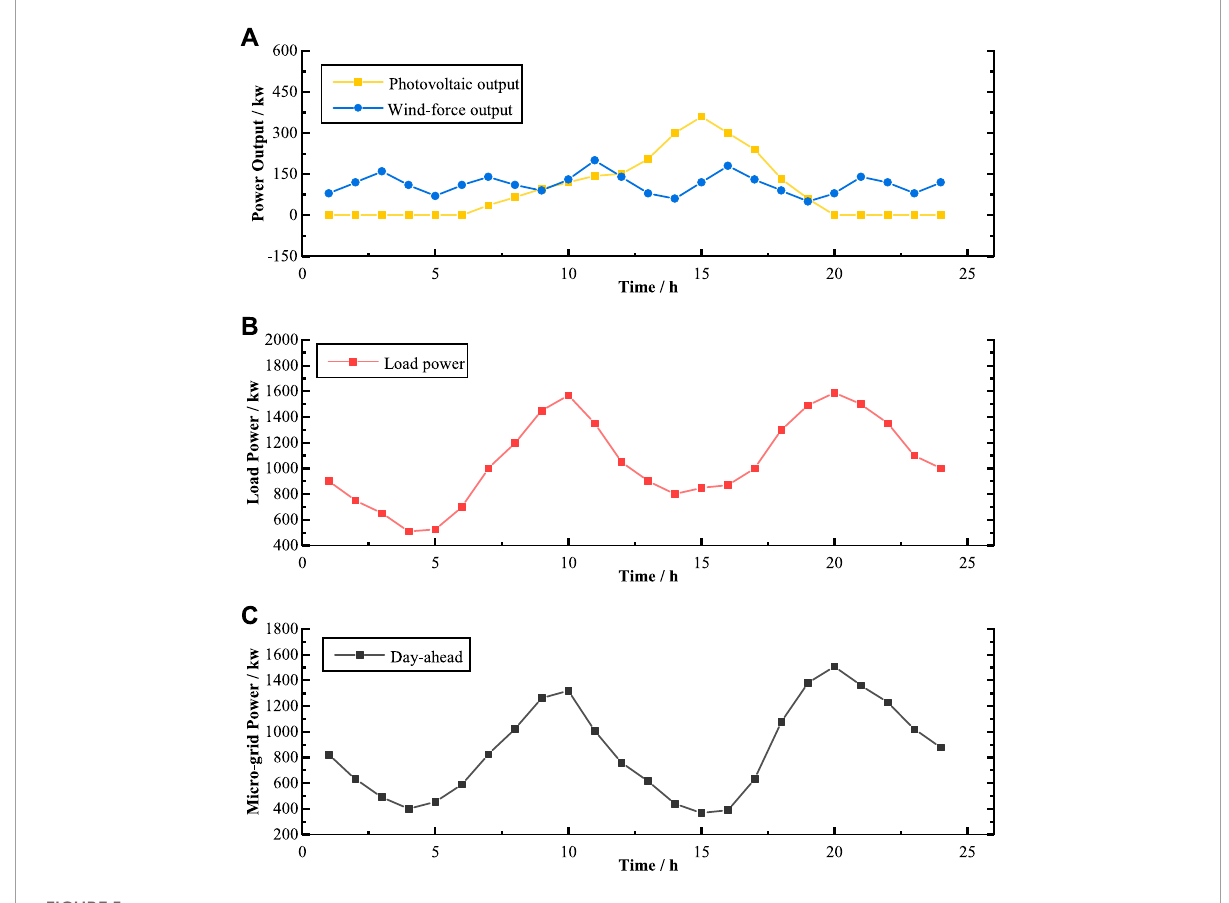
FIGURE 5 Day-ahead power curves for microgrid: (A) output power; (B) load power; (C) microgrid exchange power.